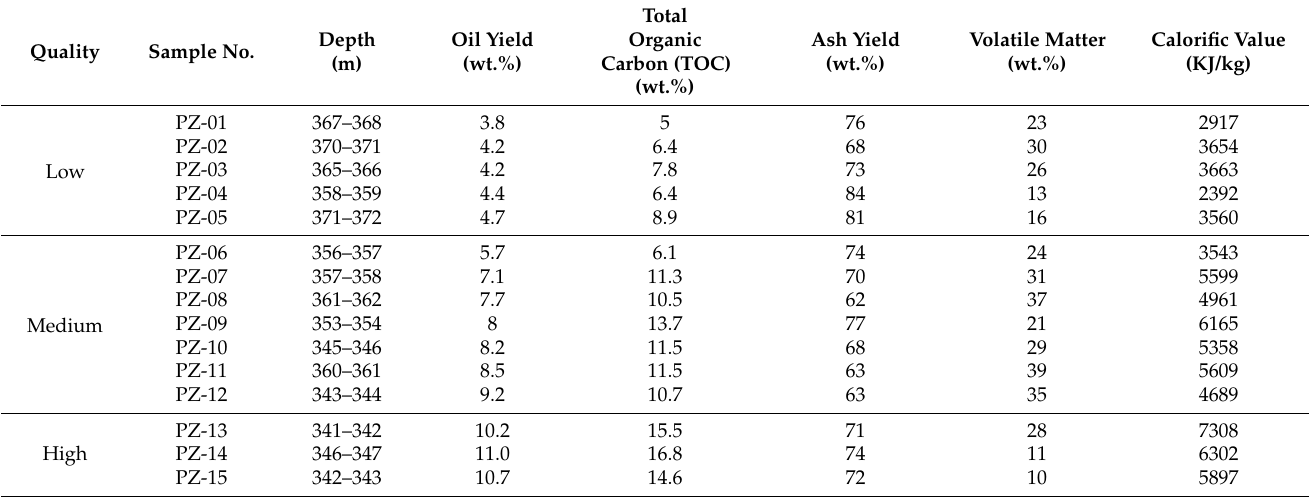
Table 1. Parameters showing the variation in different quality of oil shales from the Shale Member of the Middle Jurassic Shimengou Formation, Yuqia area, Qaidam Basin.